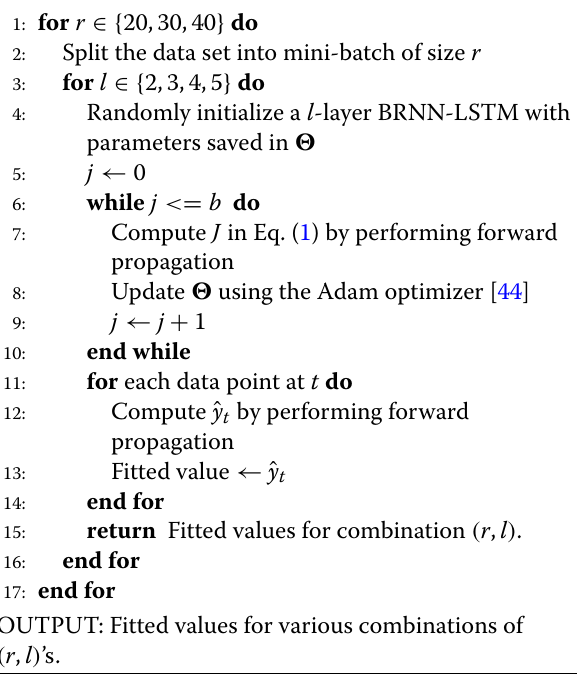
Algorithm 1 Algorithm for computing fitted values.